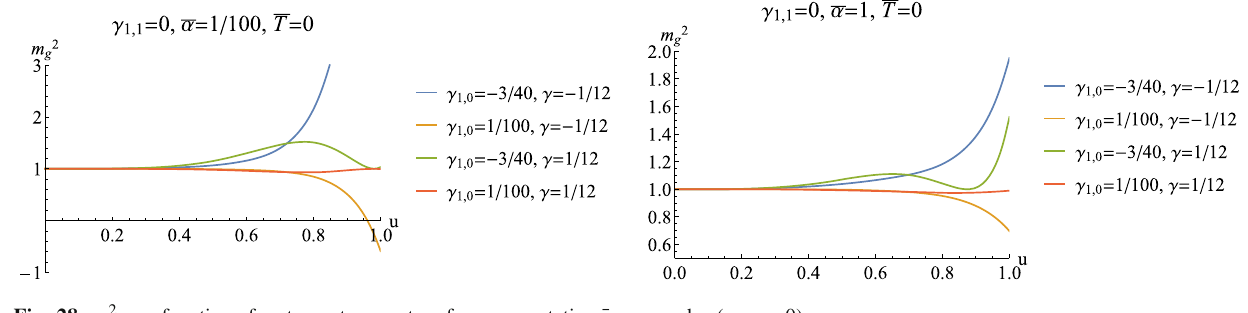
Fig. 28 m 2 g as a function of u at zero temperature for representative ¯ α , γ 1 , 0 and γ ( γ 1 , 1 = 0)